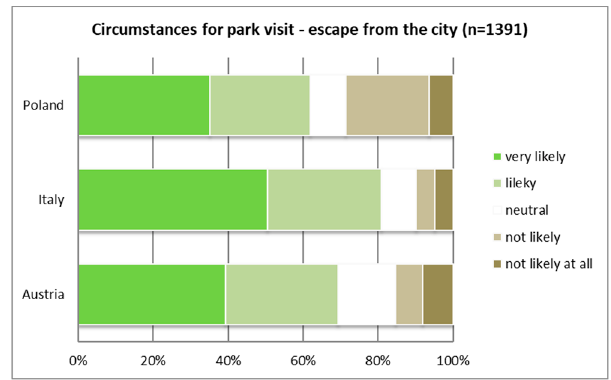
Figure 4. Visiting PAs to escape from the city; cross-country comparison ( p ≤ 0.01).